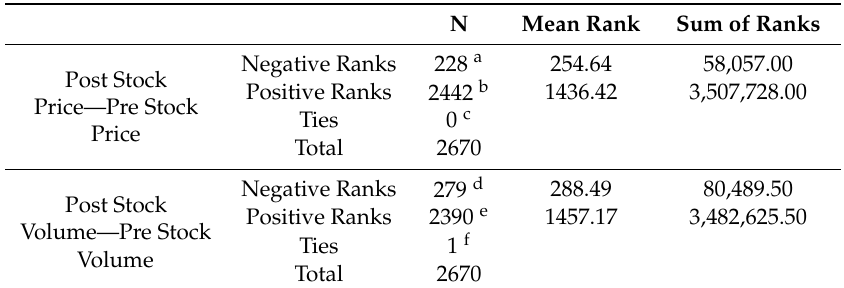
Table 1. Wilcoxon signed ranks test. N Mean Rank Sum of